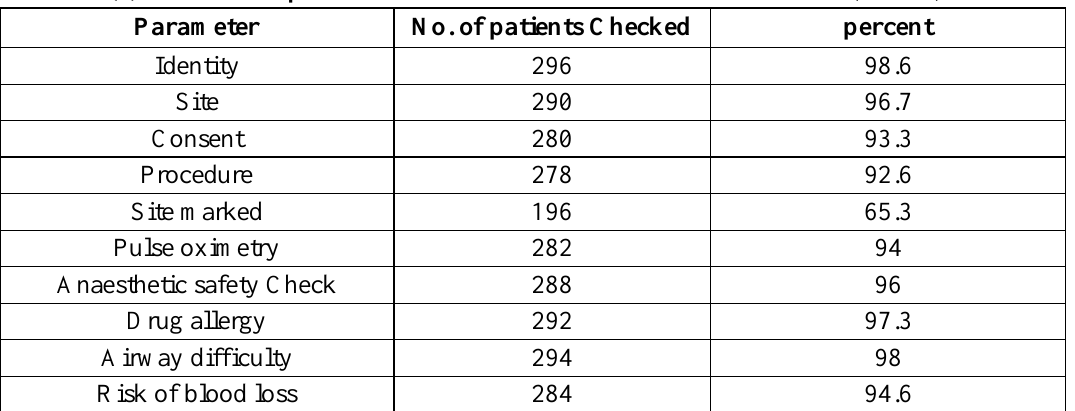
Table (1): Number of patients checked before induction of anesthesia (N=300) Parameter